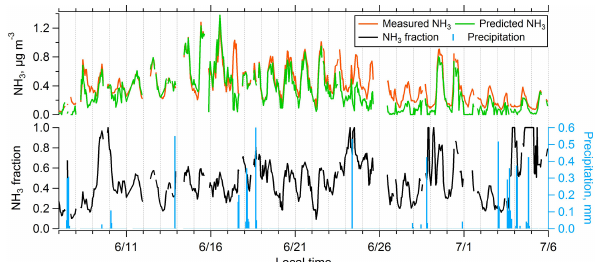
Figure 10. CTR (SOAS) time series of hourly averaged mea- sured NH 3 ( g ) , predicted NH 3 ( g ) , NH 3 ( g ) fraction (i.e., measured )) , and NH 3 ( g ) / (NH 3 ( g ) + NH + 4